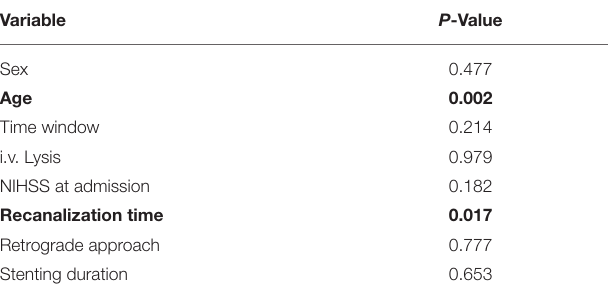
TABLE 2 | Regression analysis for favorable long term outcome